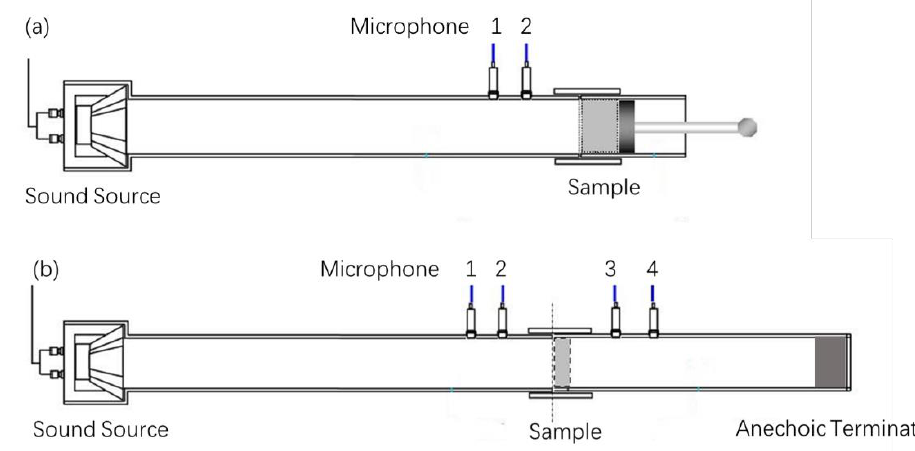
Figure 5. Schematic diagram of impedance tube for measuring sound properties. ( a ) Sound absorption coefficient testing; ( b ) transmission loss testing.